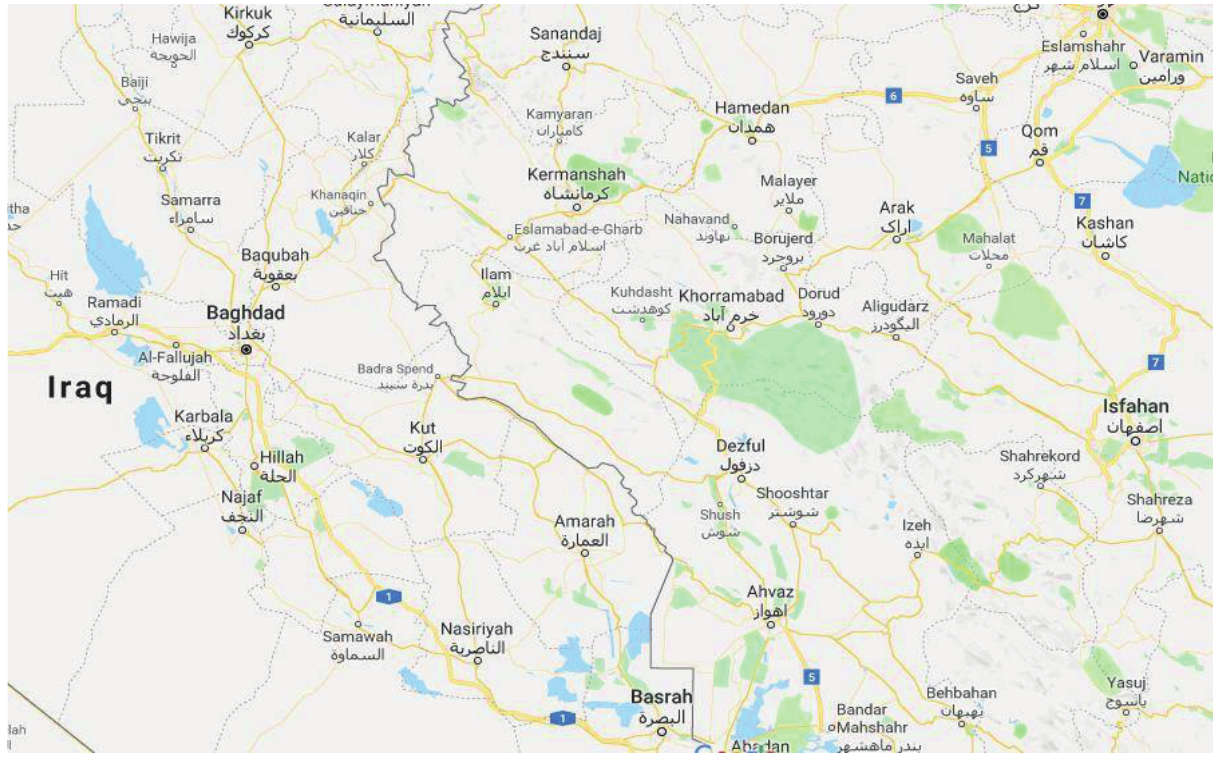
Figure 1 Geographical location of Ilam province and Iraq (Google map) Table 1 Concentrations of PM and PM in different months of sampling in Ilam province, μg/m 3 10 2.5 Months Number of Average Maximum Minimum Median Standard deviation sampling days